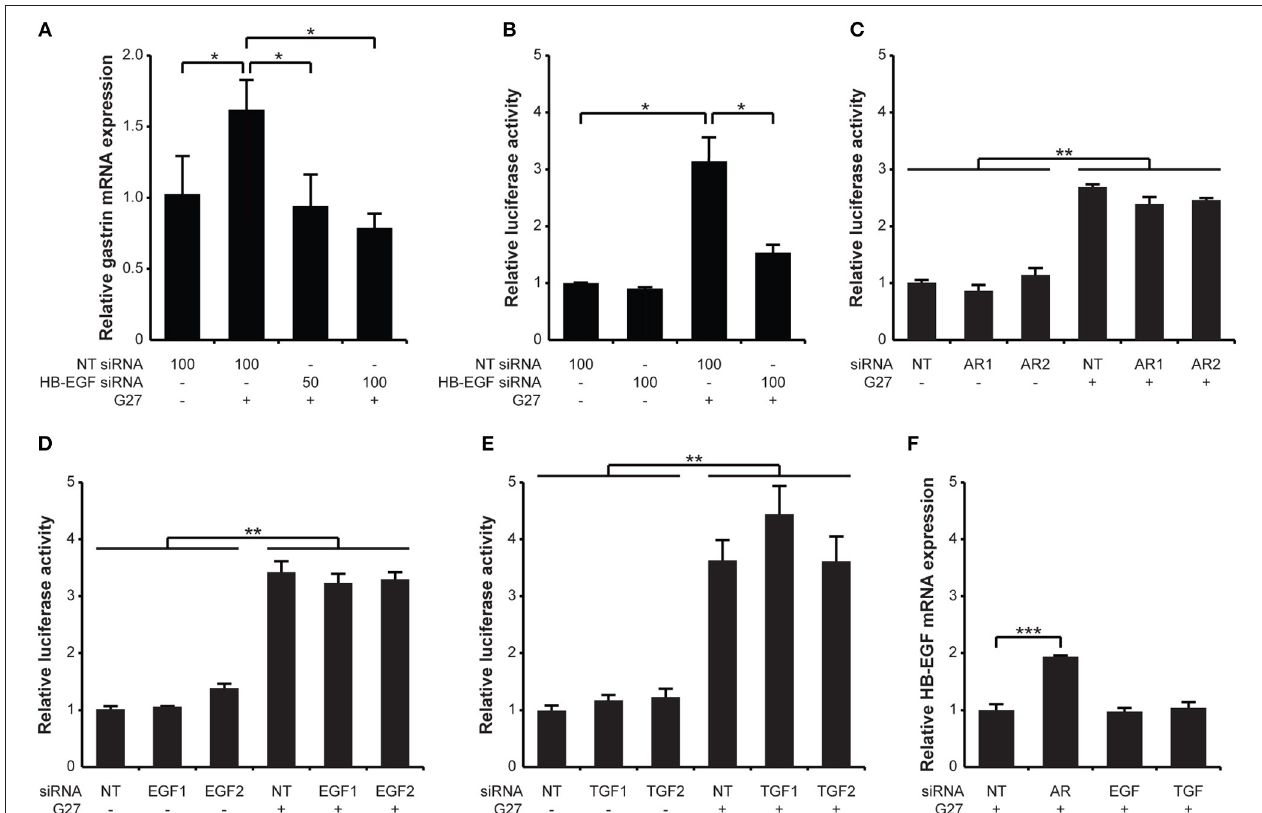
FIGURE 3 | Specific siRNA knockdown of HB-EGF inhibits H. pylori -induced transcription and promoter activity of gastrin. (A) AGS and (B) G240-Luc cells were transfected with non-targeting (NT) or HB-EGF siRNA at the indicated concentrations (50 or 100 pM). (C–E) AGS cells were transfected with 100 pM of siRNAs targeting each AR, EGF, or TGF- α . (F) AGS cells were transfected with 100 pM of siRNA (NT or EGF), or with a 1:1 mixture of 2 siRNAs (50 pM each, TGF- α or AR). Forty-eight hours post transfection, the cells were infected with H. pylori G27 for 5h. Transcription of gastrin or HB-EGF was relatively quantified to that of 18S rRNA by qRT-PCR. Promoter activity was presented as a relative ratio of the luciferase activity level to that of the NT siRNA-treated cells. Each result is presented as mean values ± SD of three separate experiments performed in triplicate. * P < 0.05, ** P < 0.01, *** P <